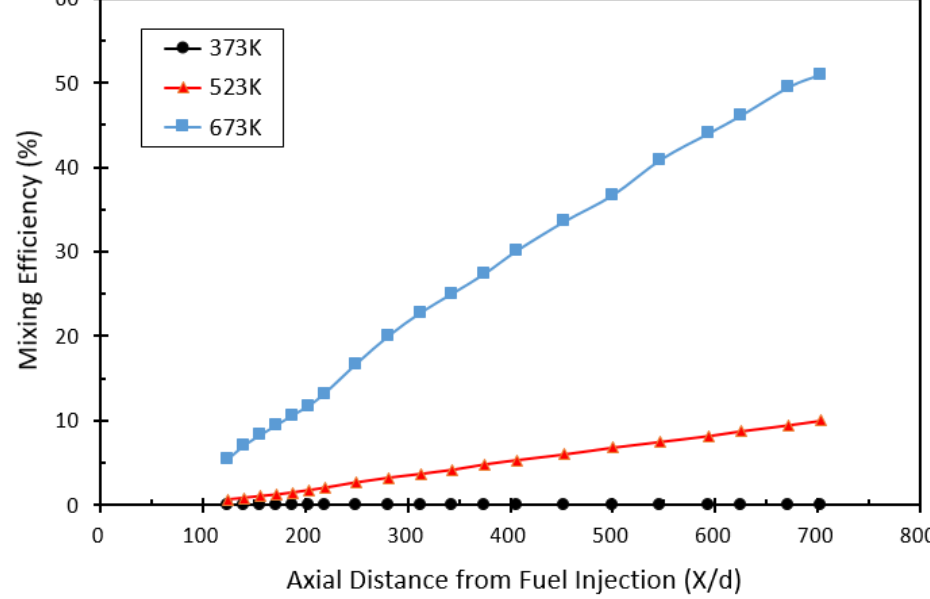
Figure 10. Comparison of mixing efficiencies downstream of the pylon for three different air tem- peratures.